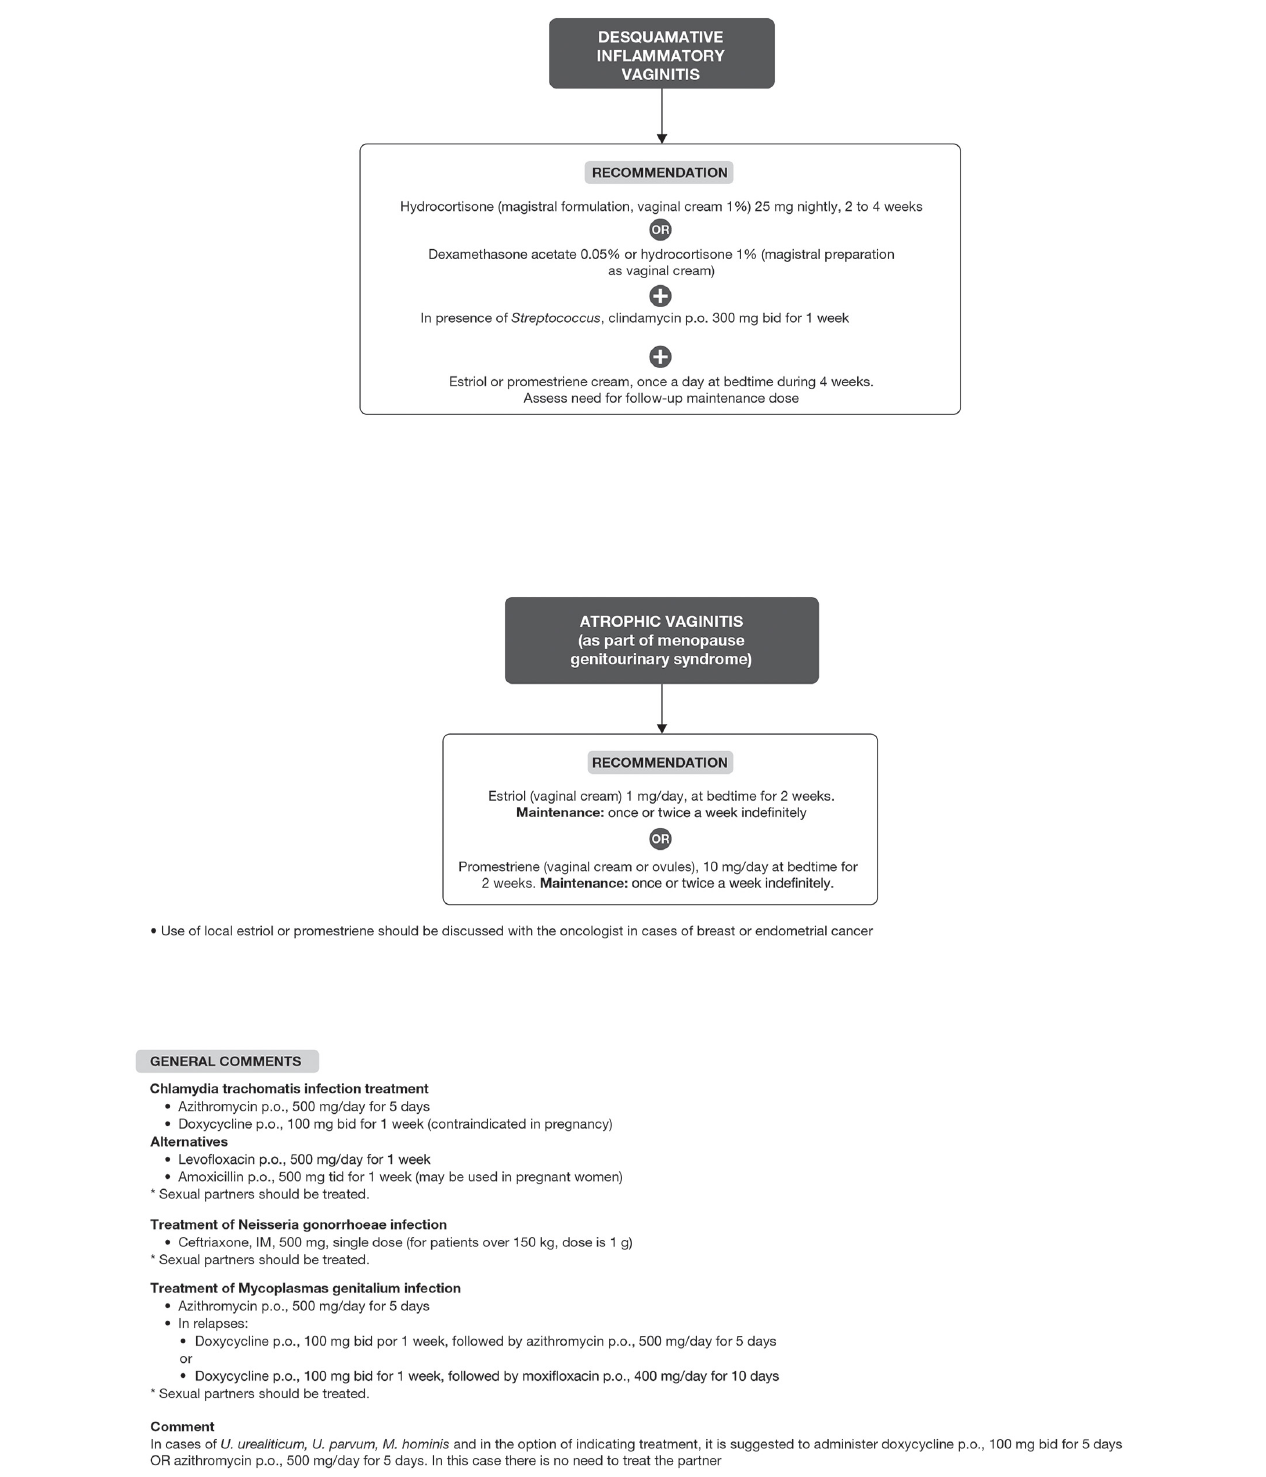
FIGURE6 Treatment for aerobic vaginitis/desquamative inflammatory vaginitis, atrophic vaginitis and